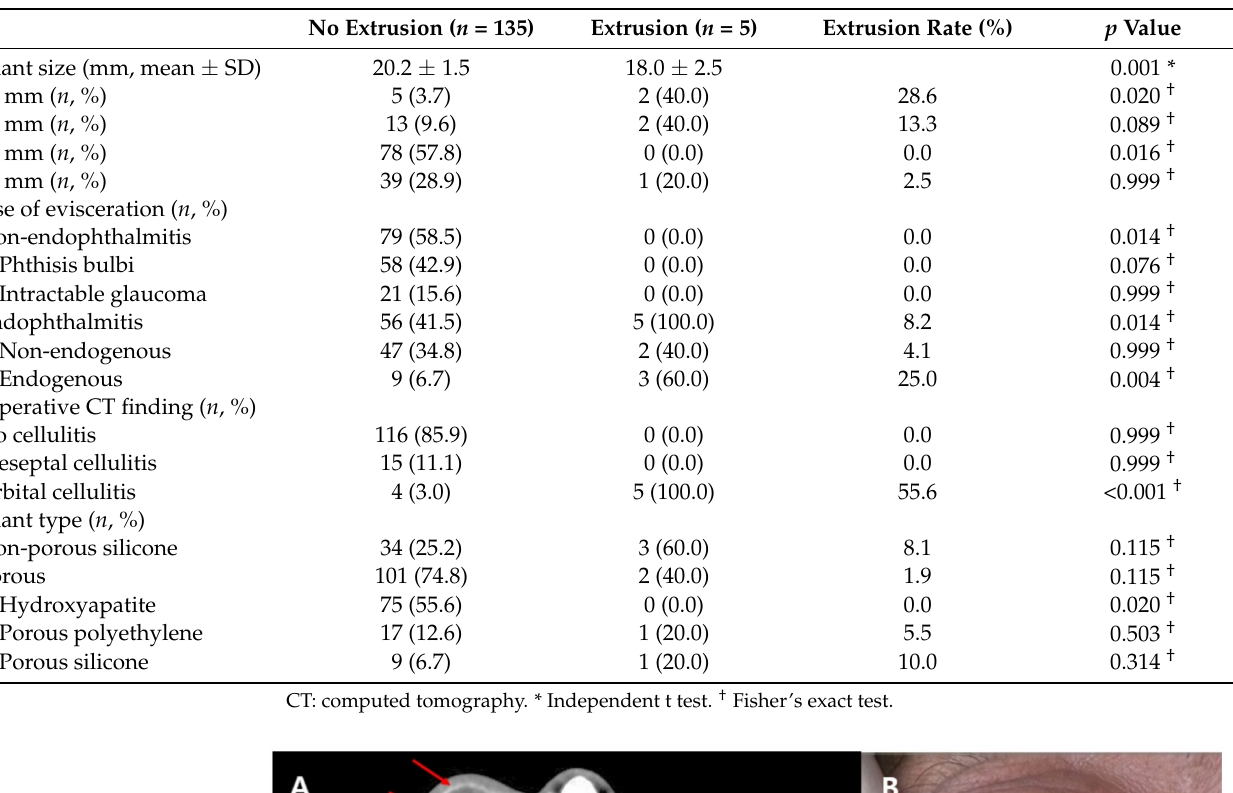
Table 2. Distribution of risk factors and extrusion rate.